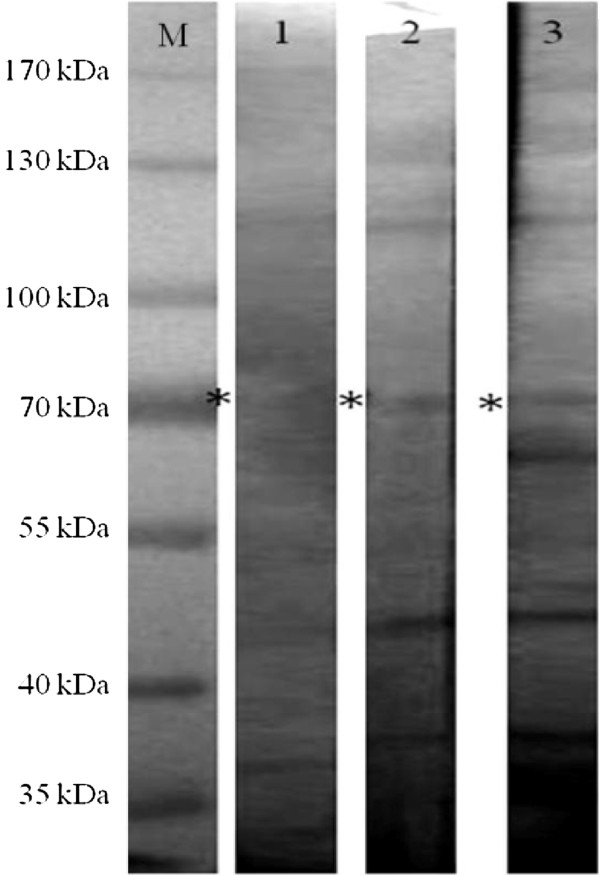
Antigenic protein profile of fractionated CSA probed with human ALA serum. Lane M: Molecular weight standard (PageRulerTM Prestained Protein Ladder); Lane 1: Pooled human ALA serum; Lanes 2–3: Individual human ALA serum; (*) indicates the targeted protein (~70 kDa).